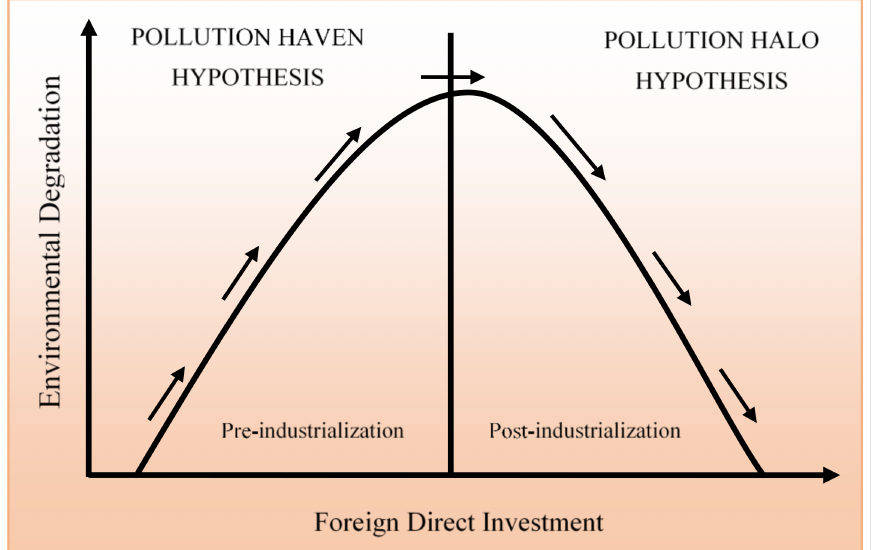
Figure 1. Inverted U-shaped link between FDI and environmental